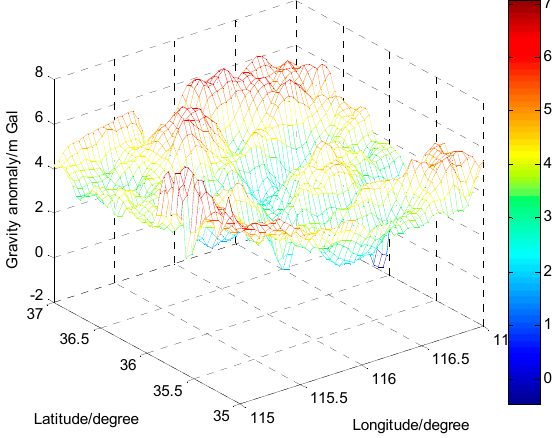
Figure 6. The gravity anomaly map in the Huabei plain area.